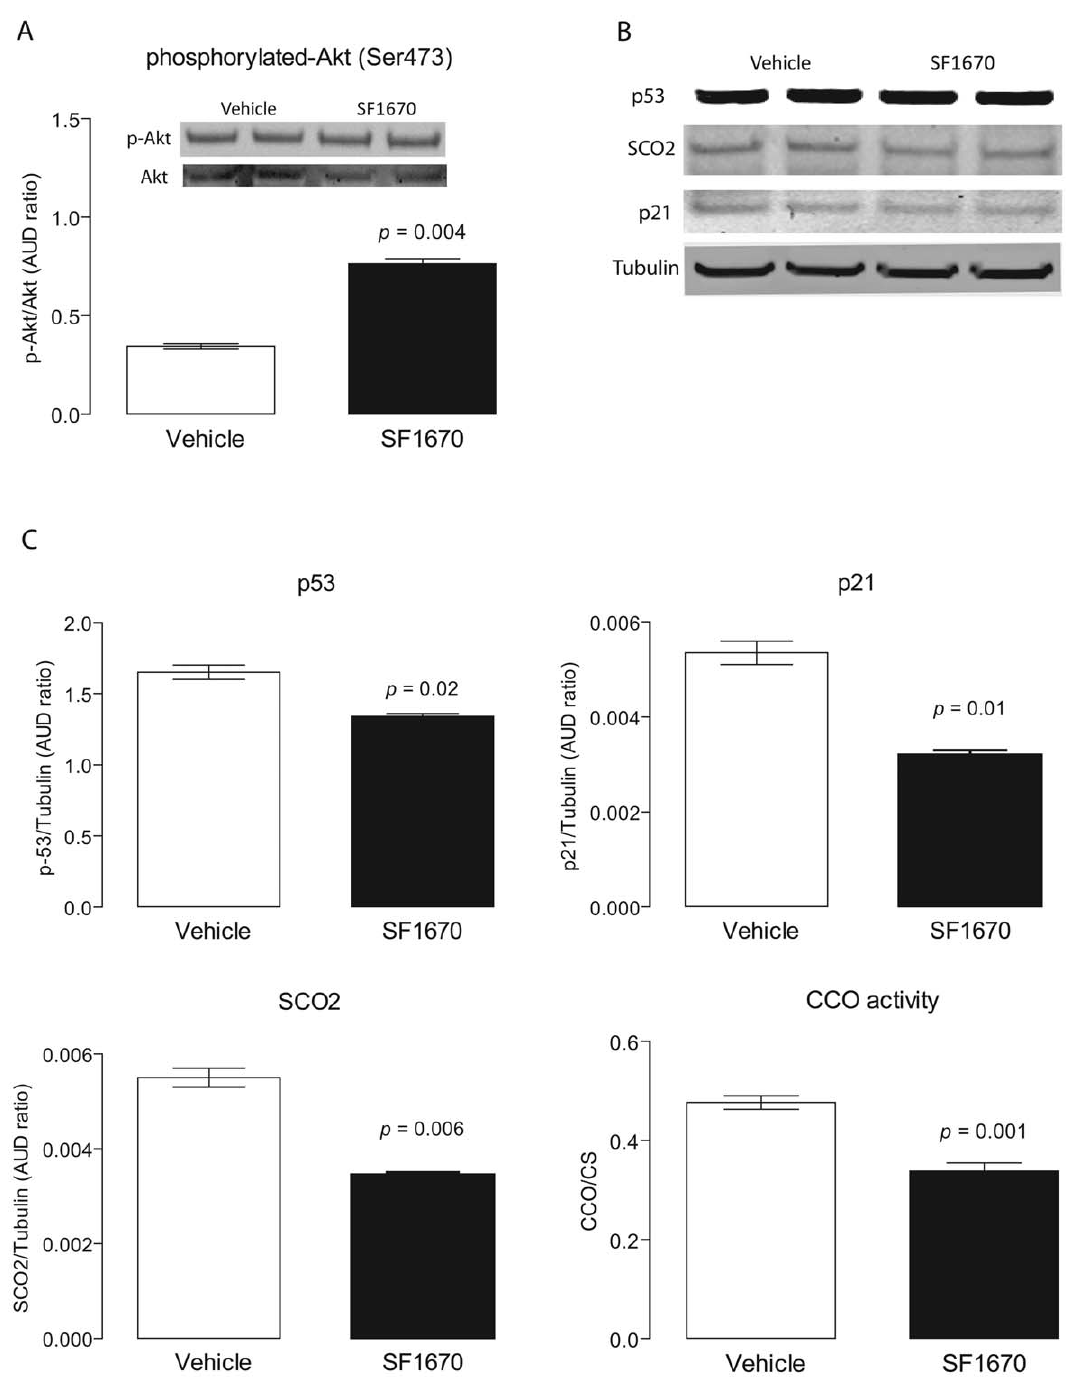
Figure 3. Protein expression of p53, p21 and SCO2 and CCO activity in Pten-deficient striatal neurons. A. Representative Western blot and densitometry of p-Akt and total Akt protein levels in striatal neurons. Results are expressed as the ratio between p-Akt and total Akt and reported as mean 6 SEM. B. Representative Western blots of p53, p21 SCO2 and Tubulin. Forty m g of protein were loaded in each lane. Details on the antibodies used are described in the Materials and Methods. C Densitometry results for p53, p21, SCO2 protein expression, normalized by Tubulin (loading control). CCO activity was expressed as nmol 6 (min 6 10 6 cells) 2 1 and reported normalized by citrate synthase. Results are mean 6 SEM of experiments in triplicates. doi:10.1371/journal.pone.0042504.g003 cerebellum and hippocampus of HET-CRE mice compared to stress. Consistent with this hypothesis, significant mtDNA dele- HET (not shown). In contrast with cerebellum and hippocampus, tions -at the segments encoding for ND4, COX3 and CYTB- no significant differences were observed in cortex from HET and ( Table 3 ) and higher MnSOD protein expression (2.5-fold of HET-CRE mice. HET; p , 0.05 and 1.4-fold of HET; p = 0.05) were observed in